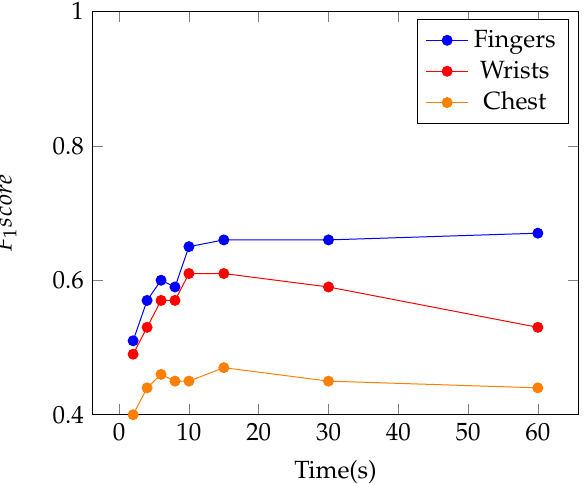
Figure 4. Plot of F1-score as a function of the duration time of the ECG segments from different